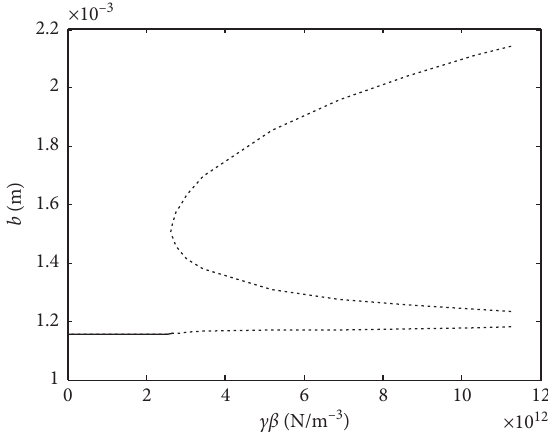
Figure 8: Amplitude-frequency curve of the rolling mill rolls as a function of parameter c β .